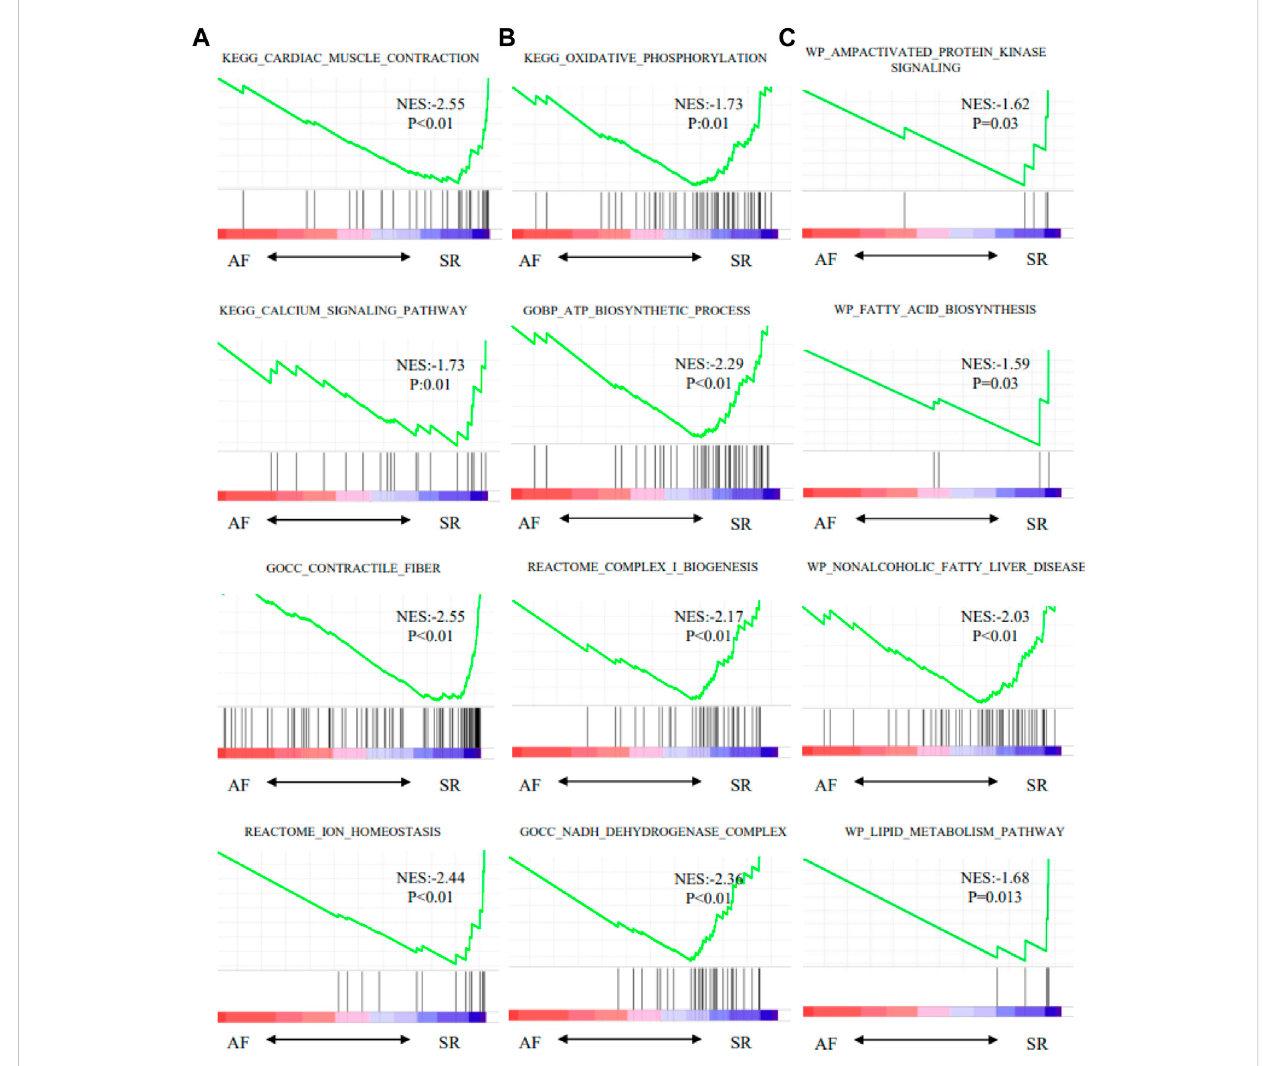
FIGURE 8 Pathways enriched by GSEA. (A) Characteristics of AF. (B) Mitochondrial metabolism pathway. (C) Glycose and lipid metabolism